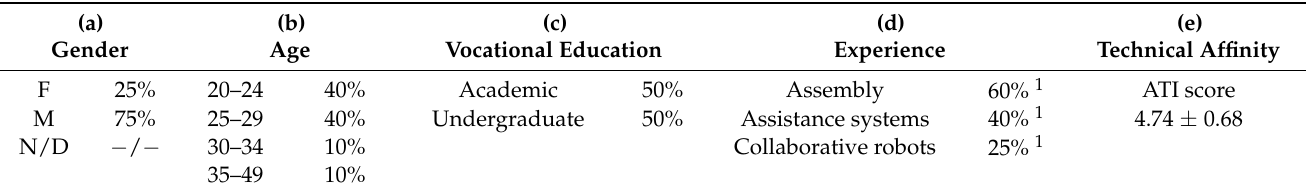
Table 3. Demographic and experience data for the subjects in the user study: (a) gender information; (b) age information; (c) vocational education information; (d) previous experience in manual assembly, use of assistance systems in industrial contexts, and programming or working with collaborative robots; (e) technical affinity